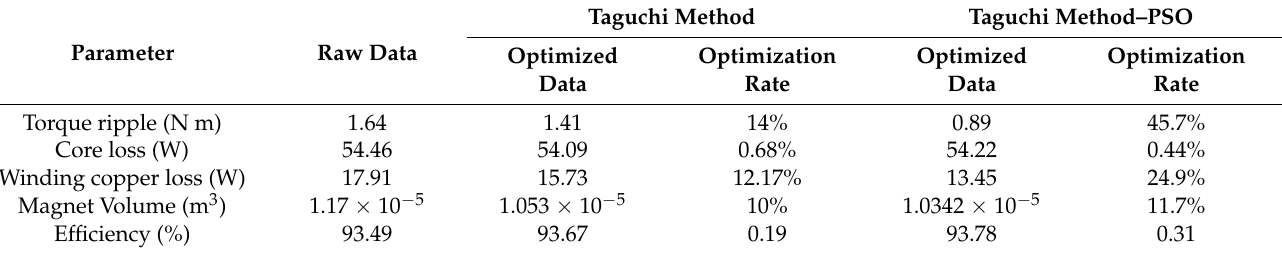
Table 6. Optimization